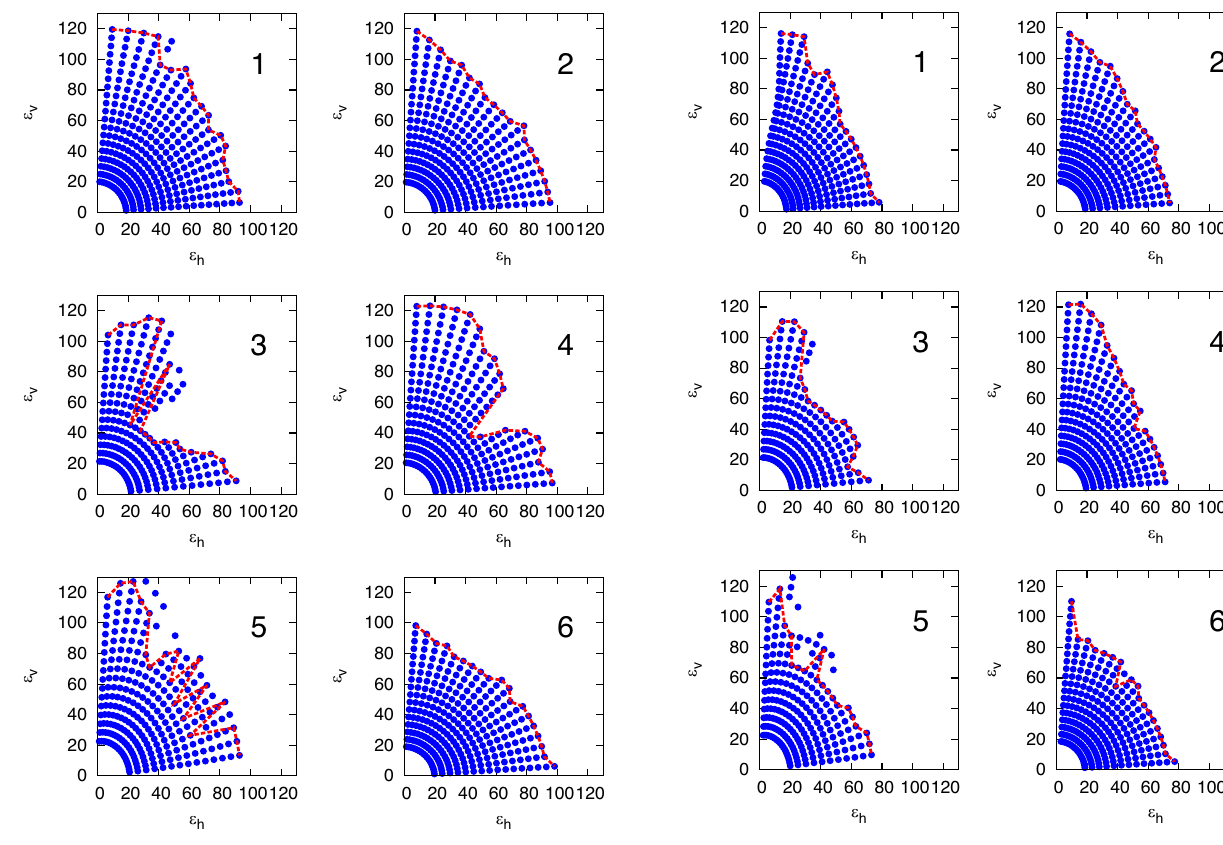
FIG. 9. Initial emittances plotted in units of π mm mrad for particle with dp=p ¼ 0 . The horizontal axis corresponds to the horizontal initial emittance and the vertical axis to the initial vertical emittance. Only those initial conditions are plotted which survived N ¼ 10 4 turns. The numbers in the upper right corners correspond to the numbering in Fig. 8. The lines indicate the last connected initial emittances for each angle α k .